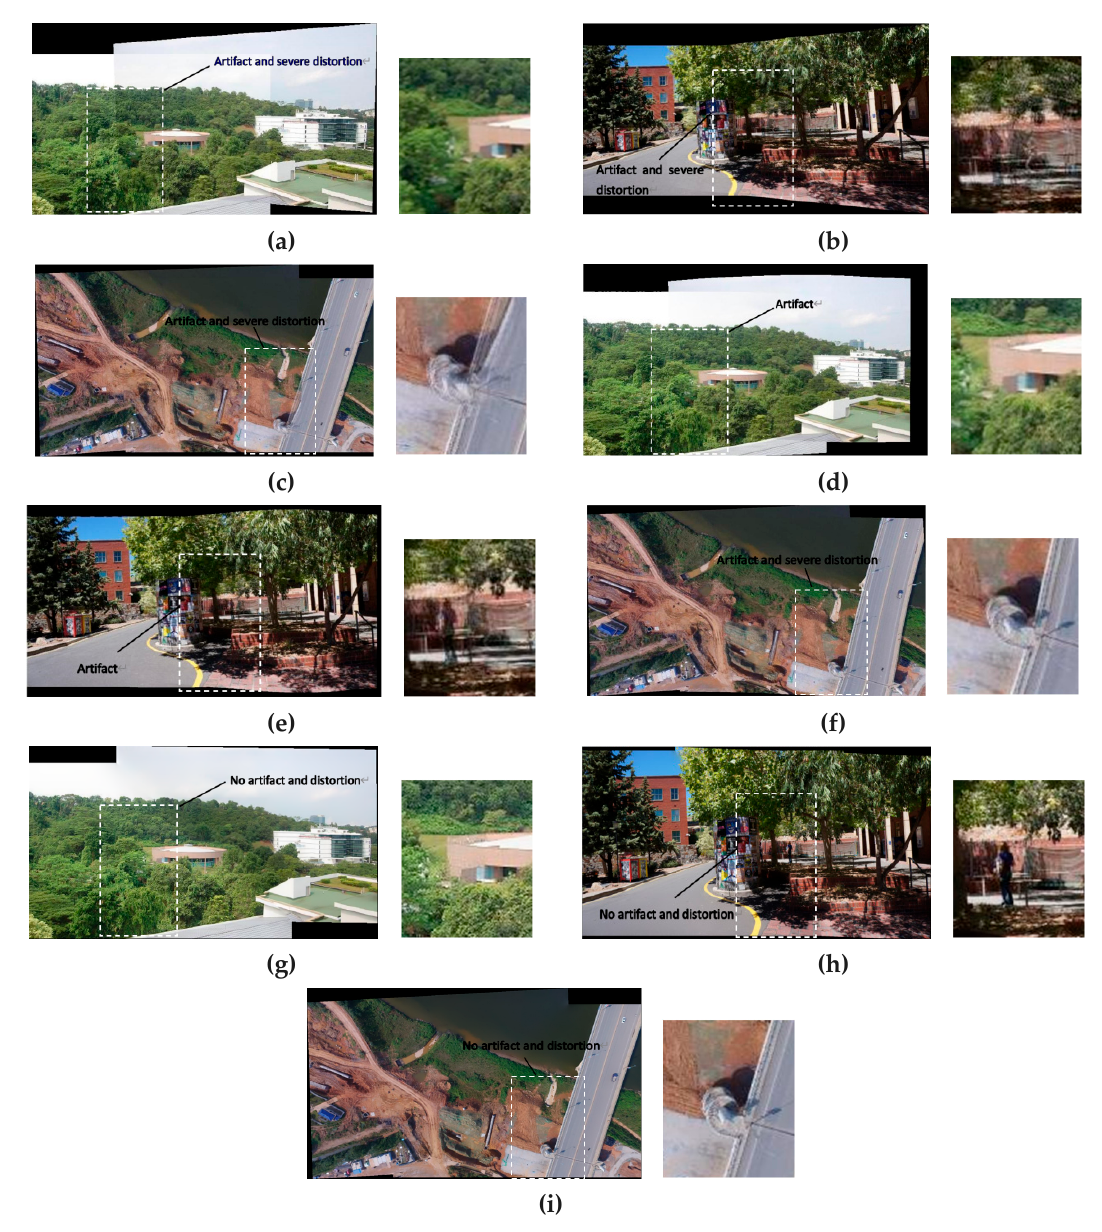
Figure 2. Ablation experiments on Forest, Road, and Bridge dataset. ( a – c ) show stitching results of the APAP. ( d – f ) show stitching results of the APAP with local and global similarity constraints. ( g – i ) show stitching results of the APAP with local, global similarity constraints and line protection constraints (One area of each result is enlarged in the